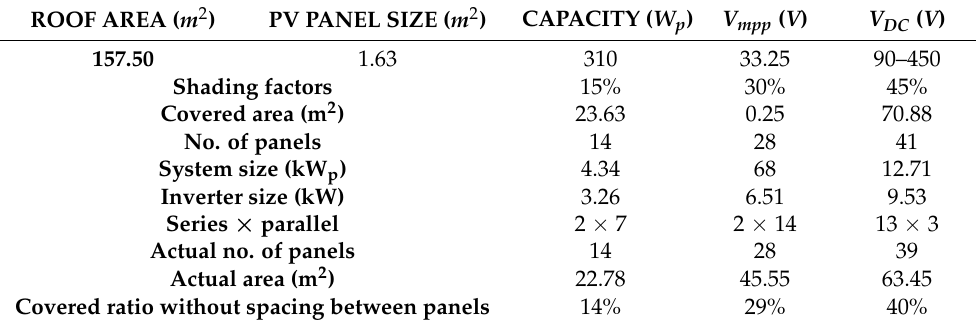
Table A3. Rooftop PV Design Variants.